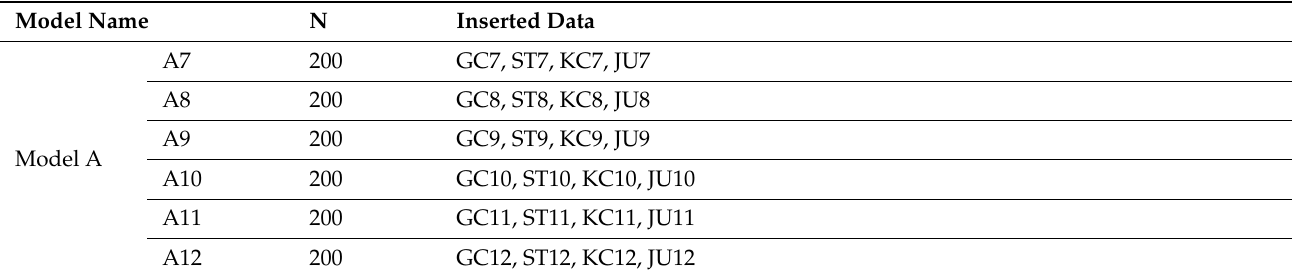
Table 1. Developed partial least square